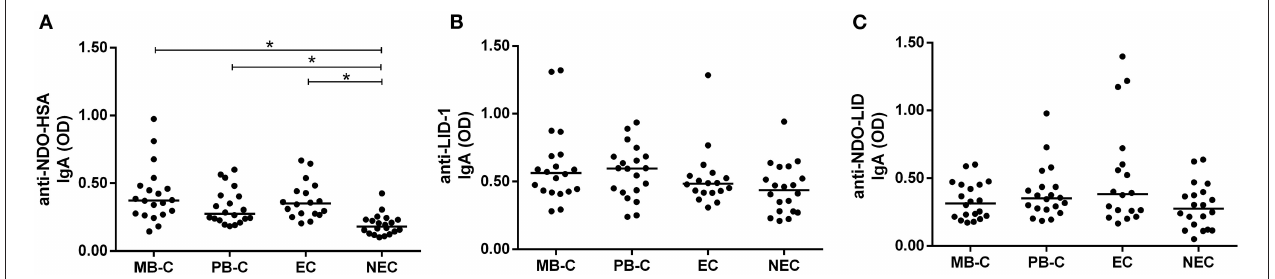
FIGURE 2 | Serum IgA responses against (A) NDO-HSA, (B) LID-1, and (C) NDO-LID in household contacts of paucibacillary (PB-C; n = 20) and multibacillary (MB-C; n = 20) leprosy patients, and in endemic (EC; n = 18) and non-endemic (NEC; n = 20) controls. The horizontal bars represent median OD determined by ELISA. * = P <